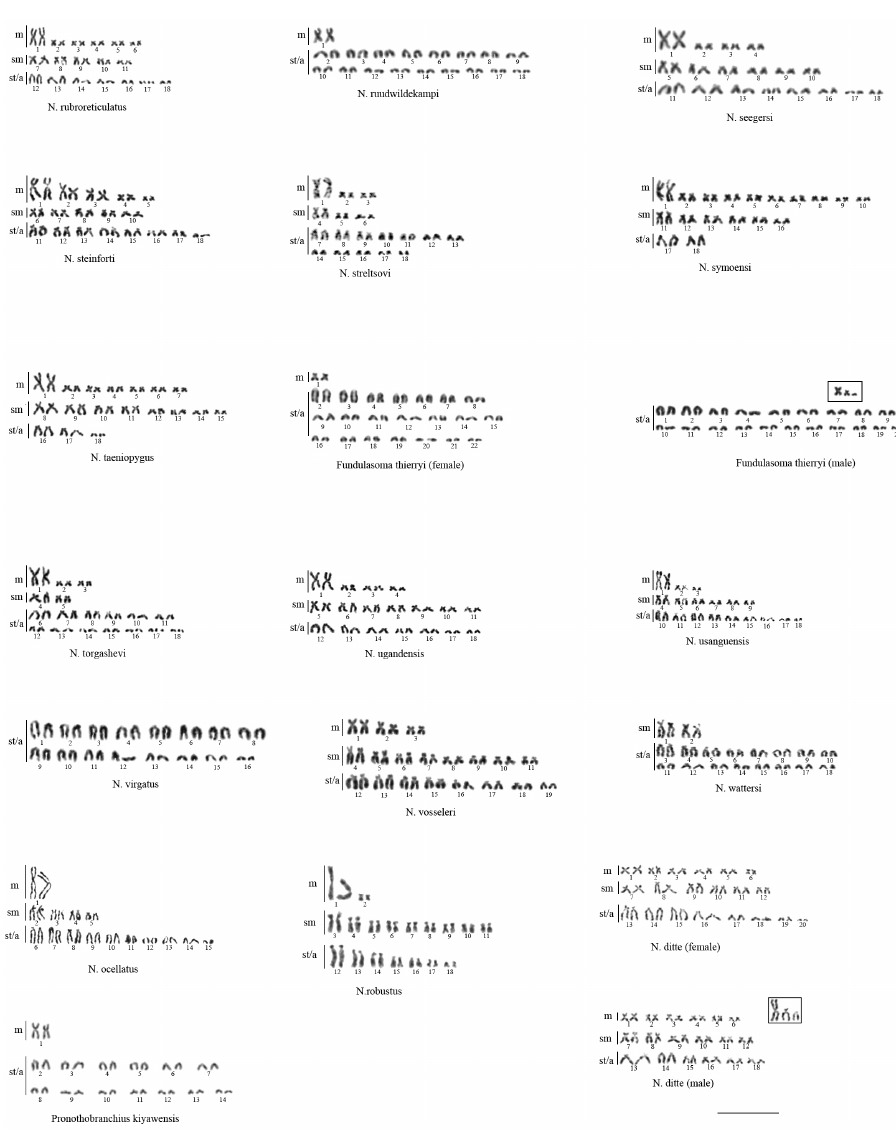
Figure 1. Continued. Karyotypes of species Nothobranchius . Scale bar: 10